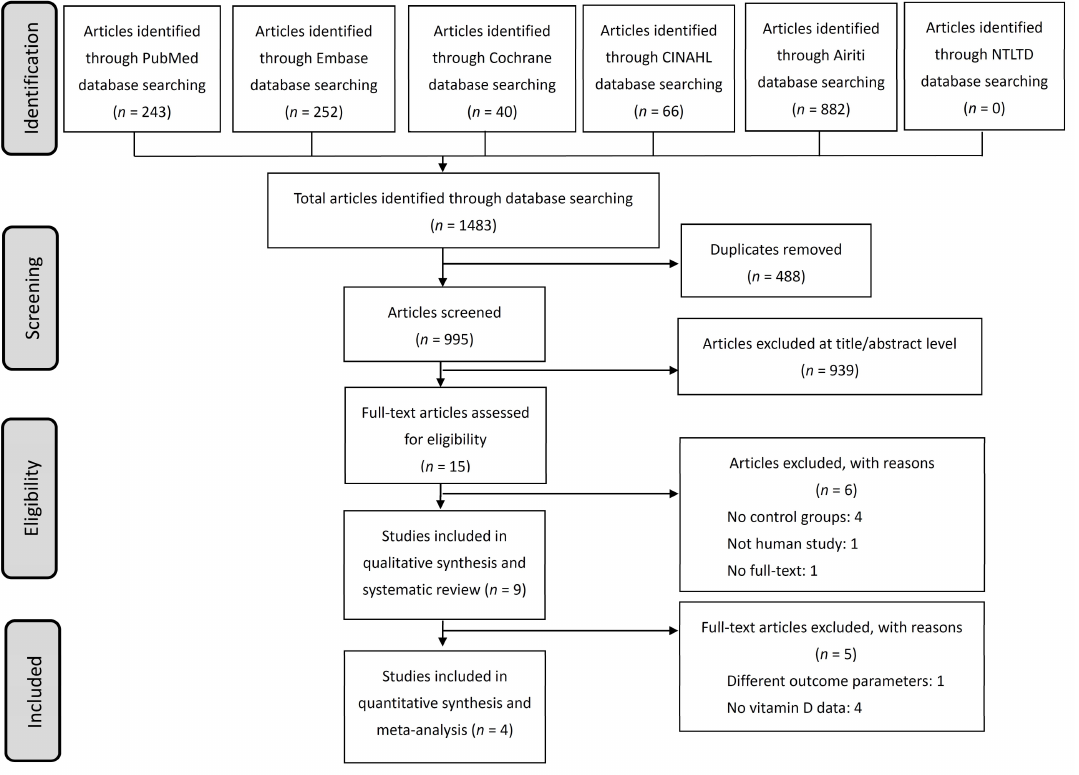
Figure 1. Schematic illustration of the literature search and the study-selection criteria. CINAHL = the Cumulative Index to Nursing and Allied Health; Airiti = Art Image Indexing Service on the Internet Database; NTLTD = the National Digital Library of Theses and Dissertations in